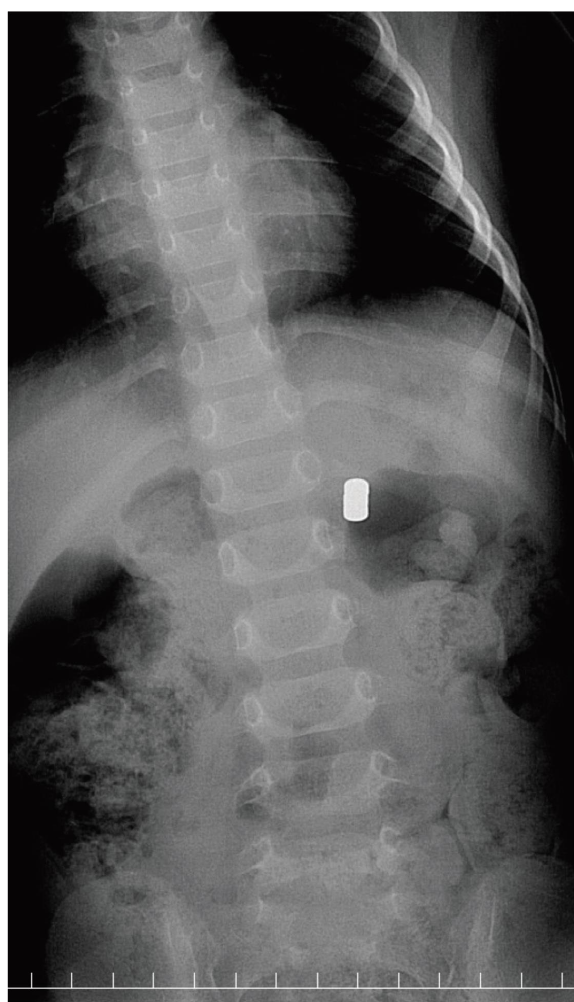
Figure 1: Abdominal radiography revealed a foreign body in the left upper quadrant, which were the three circular